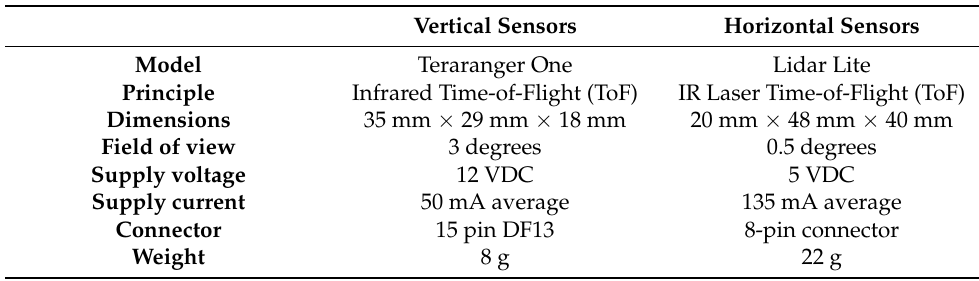
Table 1. Distance sensors used in OVDS.